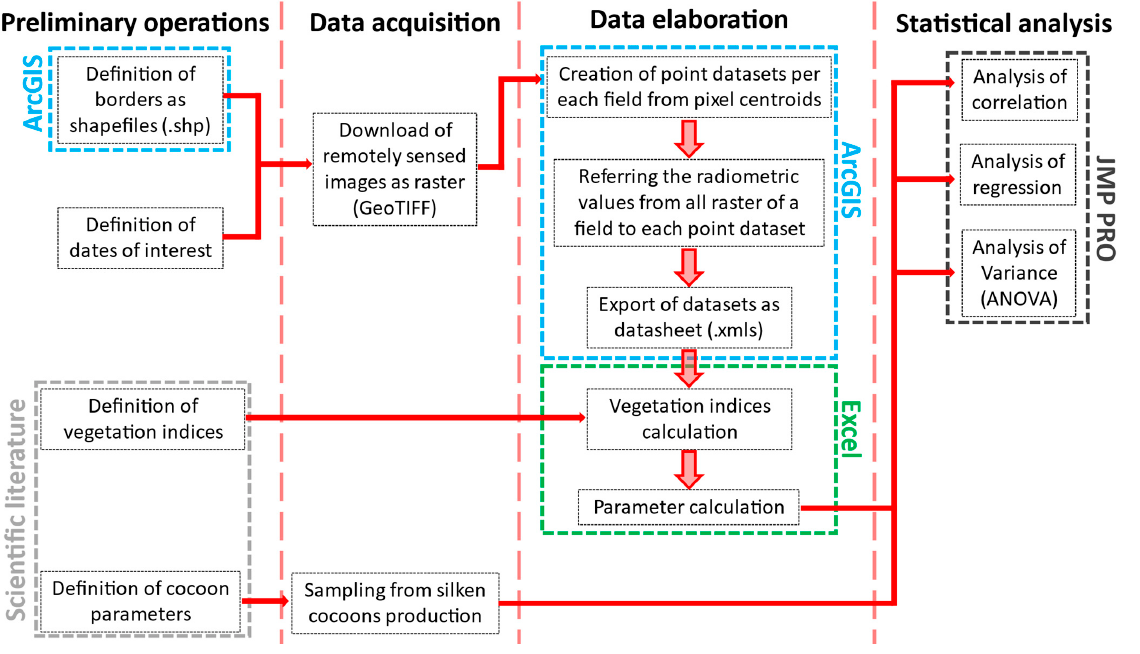
Figure 1. Schematic resume of working procedure.